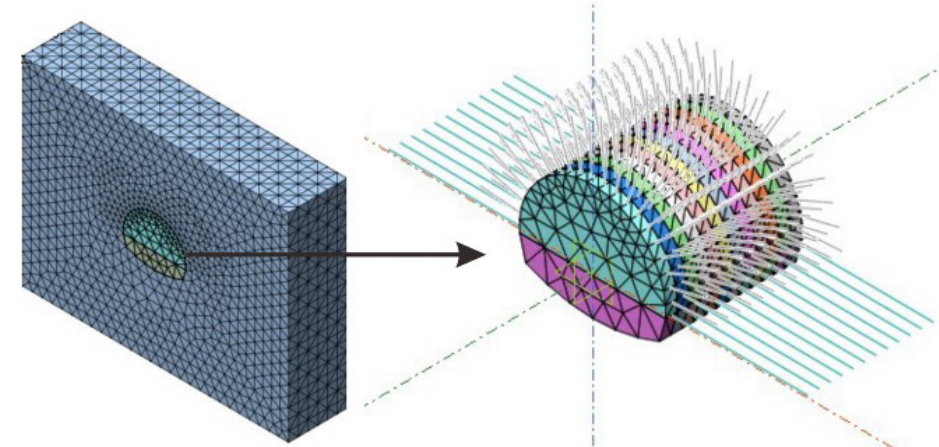
Figure 2. Three-dimensional finite-element analysis model of the composite cantilever support